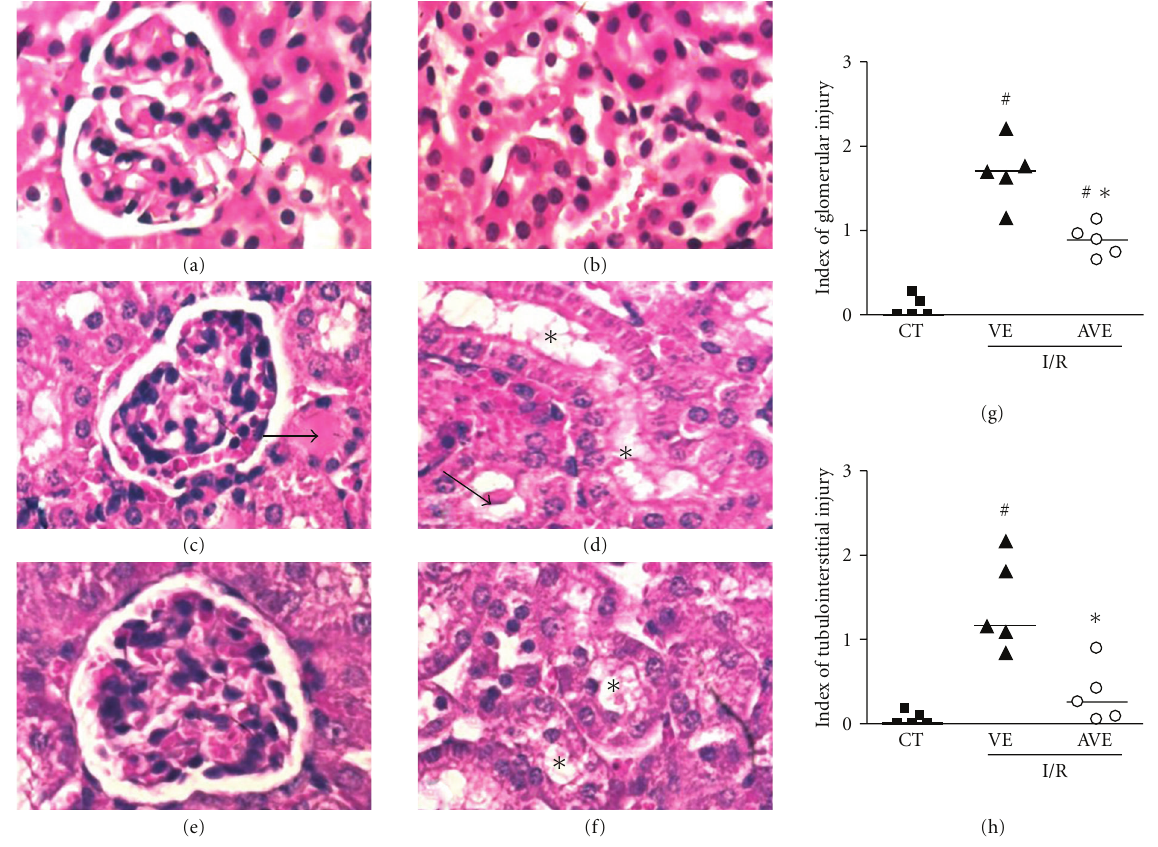
Figure 2: E ff ects of the treatment with AVE0991 in histological injury in a model of renal ischemia and reperfusion in mice. AVE0991 (AVE, 9.0mg/kg) or vehicle (VE; 10mMKOH in 0.9% NaCl) was given immediately after ischemia and 12h after reperfusion. All analyses were performed at 24 h after reperfusion. Representative photomicrographs show H&E-stained sections from sham-operated animals (CT, a, b) and animals subjected to I/R, which were treated with vehicle (VE, c, d) and AVE0991 (AVE, 9 mg/kg, e, f). There was severe renal damage with vacuolization of tubular epithelium (c) (insert) and tubular dilation and protein casts (arrow) and extensive tubular necrosis (d) in mice subjected to I/R. Original magnification: × 600. Index of glomerular injury (g) and index of tubulointerstitial injury (h) were graded in a blind manner, as described in Material and Methods. Symbols represent results in single animals, and the trace is median value for all animals. ∗ P < 0 . 05 when compared with VE-treated group; # P < 0 . 05 when compared with